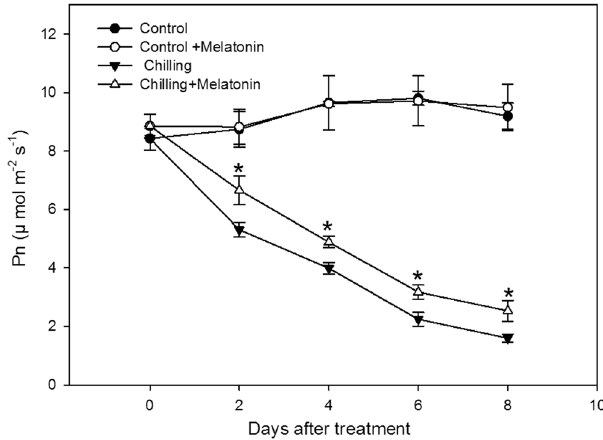
Figure 2. Effects of exogenous melatonin on net photosynthesis rate (Pn) under chilling stress. Control, treating at 28/18 °C; Control + Melatonin, pre-treating with 200 μ M melatonin and treating at 28/18 °C; Chilling, treating at 15/8 °C; Chilling + Melatonin, pre-treating with 200 μ M melatonin and treating at 15/8 °C; Date represent means ± SD of third replicate